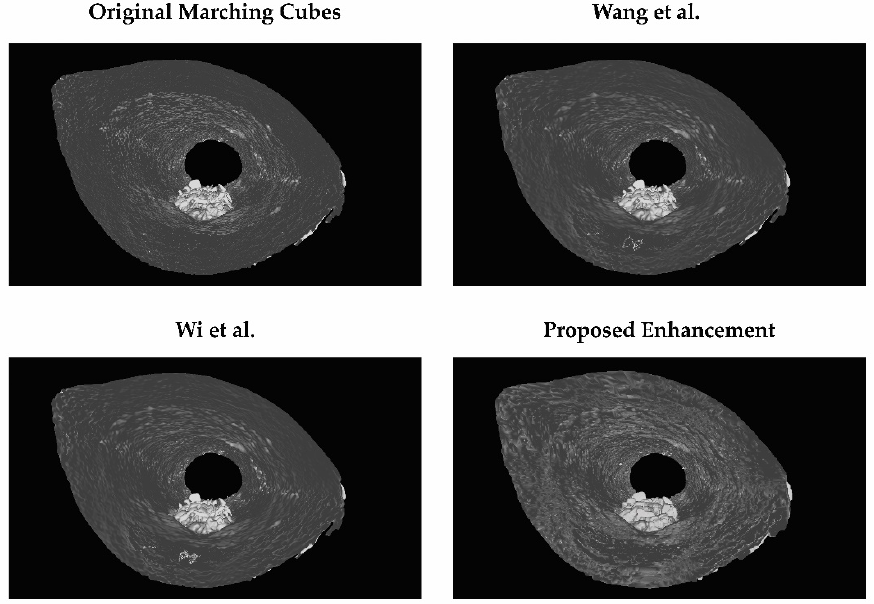
Figure 22. 3D models reconstructed with different reconstruction methods.